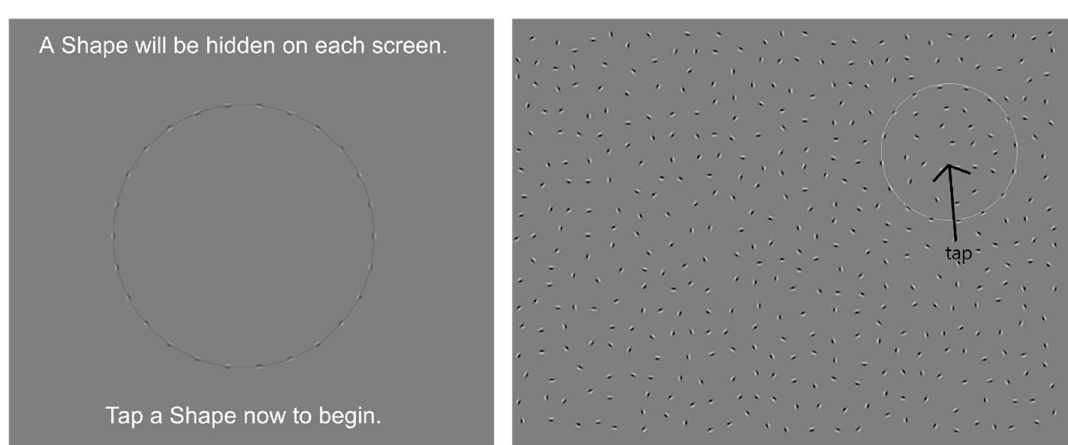
Figure 4. Contour integration task. Gabors appeared on a gray background. Participants were asked to tap on the circle that was formed by the Gabors. The contour is outlined for illustrational